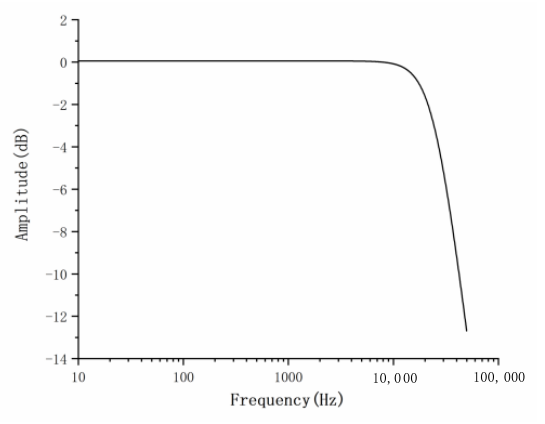
Figure 9. Amplitude–frequency response characteristics of the filter circuit.